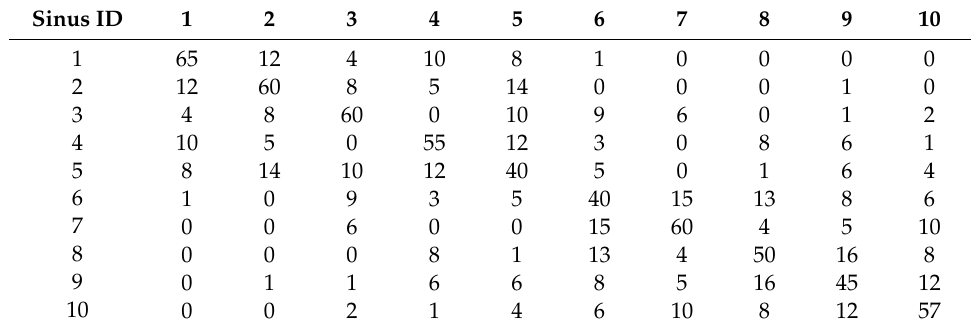
TableA1. ProbabilityofanagenttoconnectwithanotheragentaccordingtotheSinus-Milieus ® category.